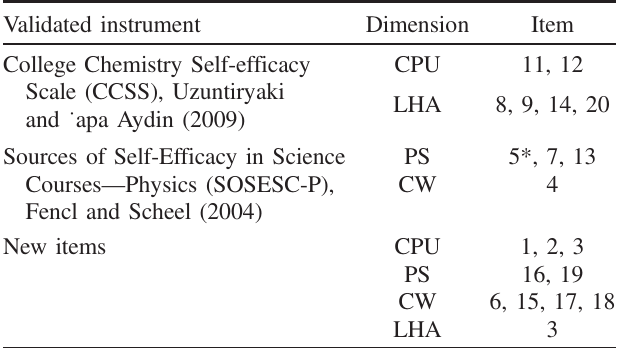
TABLE I. Previous items gathered from published physics self- efficacy surveys and the new ones.